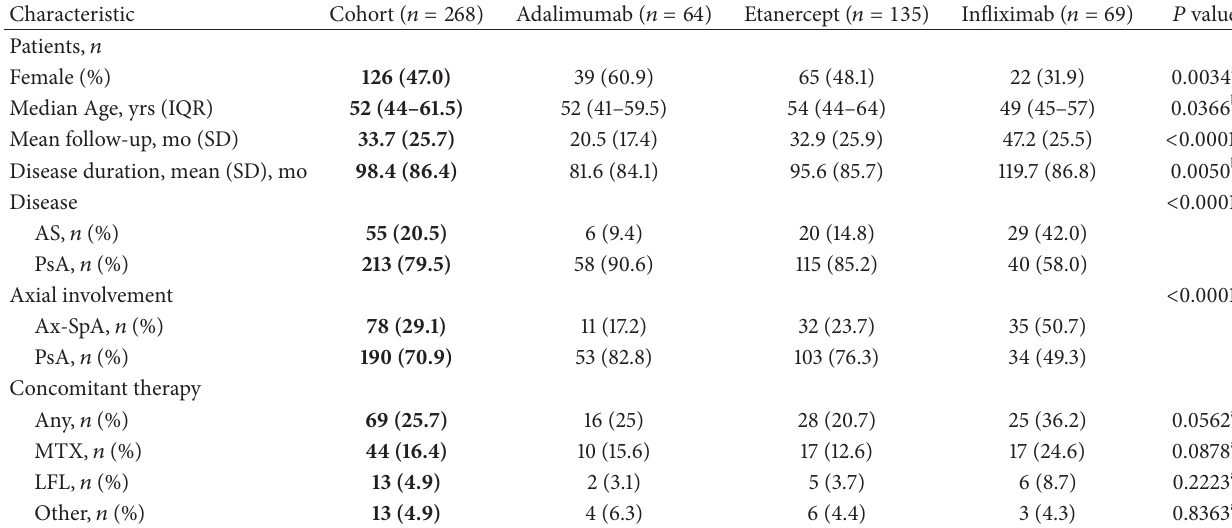
Table 1: Demographic and disease characteristics by initial anti-TNF- 𝛼 treatment and for the cohort.